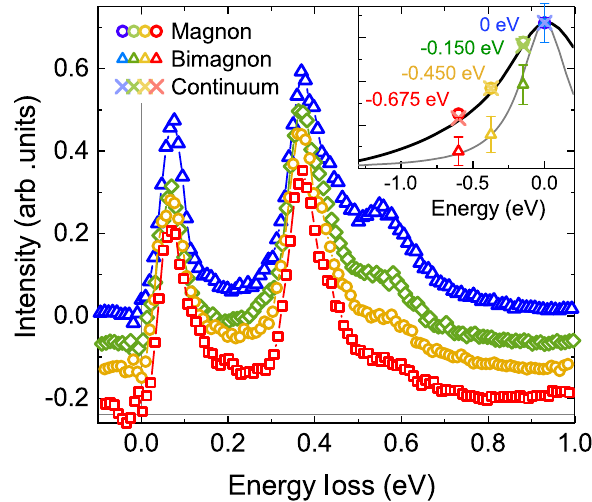
FIG. 6. Inelastic RIXS spectra at different incident energies. The elastic line has been removed for clarity. All the spectra are acquired at ( − 0 . 43 ,0) using σ polarization, in order to have appreciable intensity for both the magnon and bimagnon signals. The scans have also been normalized to the value of the XAS. The inset shows the XAS signal (solid black line), the intensity of the magnon peak (circles), of the continuum (crosses) and of the bimagnon (triangles). The gray solid line is a guide to the eye. All intensities have been normalized to the resonance value, and the energies are referred to the maximum of the XAS (931.6 eV). The errors on the intensity of the continuum and the magnon are of the size of the